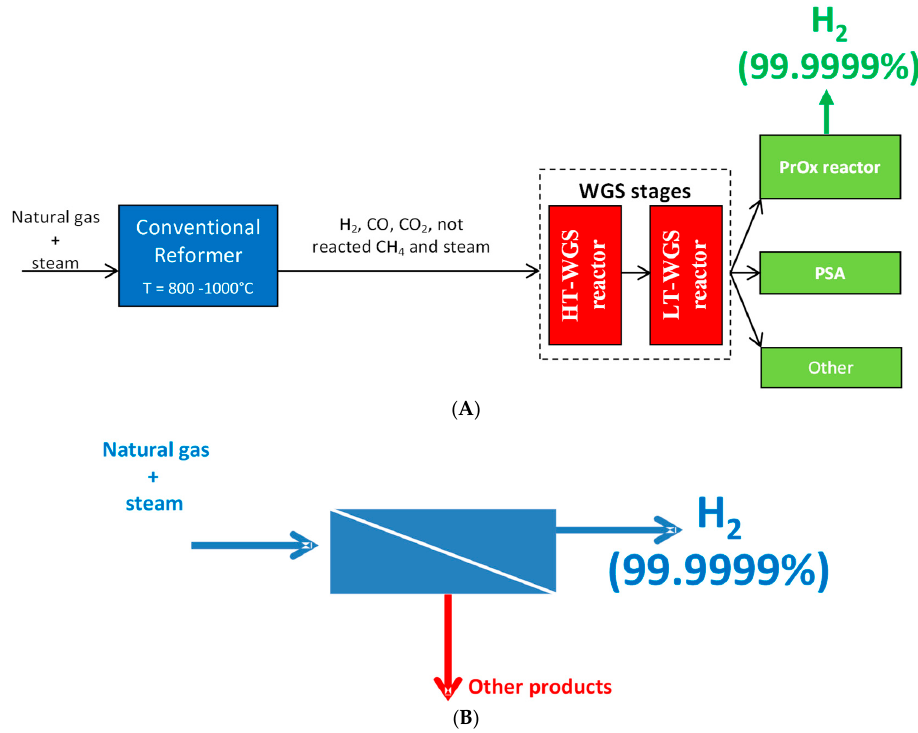
Figure 3. High grade hydrogen generation performed in: ( A ) a multi-stages conventional process; and ( B ) a MR housing a H 2 perm-selective membrane.